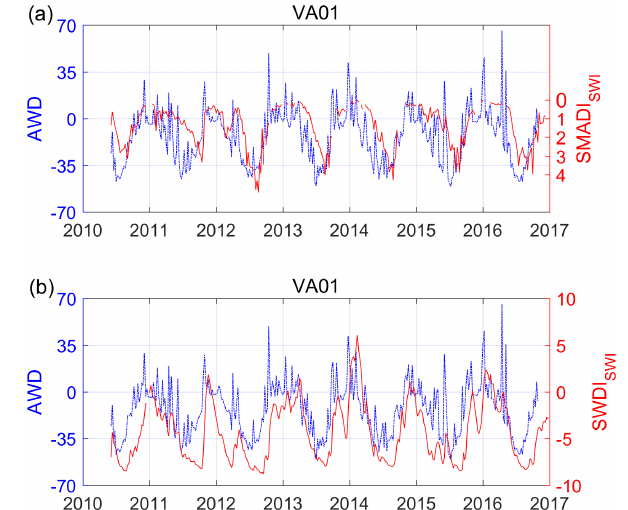
Figure 4. Time series of the weekly CMI and SMADI SWI (a) , and SMDI SWI (b) at the Soria station of the AEMet, as an example. Since SMADI = 1 and CMI = 0 are the threshold for drought (Pab- los et al., 2017), both values coincide in the y -axis. In addition, note that the y -axis of SMADI is oriented